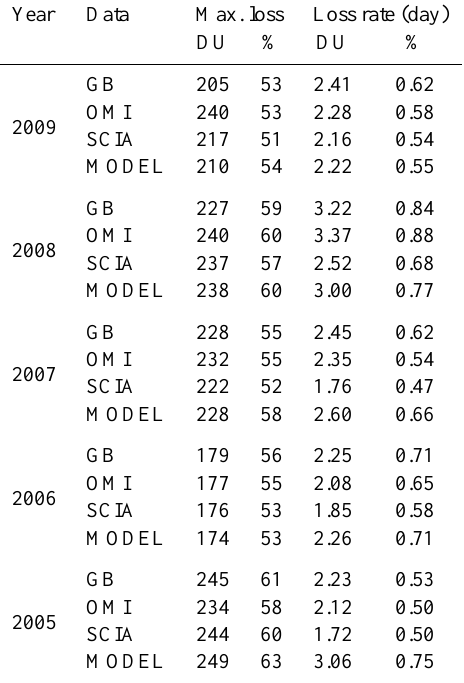
Vortex averaged ozone loss (ten-day boxcar aver- age) estimated from the ground-based (GB), OMI and SCIA- MACHY (SCIA) observations and the total column integrated from REPROBUS (2006–2009) and SLIMCAT (2005) simulations (MODEL), during recent Antarctic winters. Extrapolated data are used for day 225 to calculate the ozone loss rates in 2007 and 2009 from